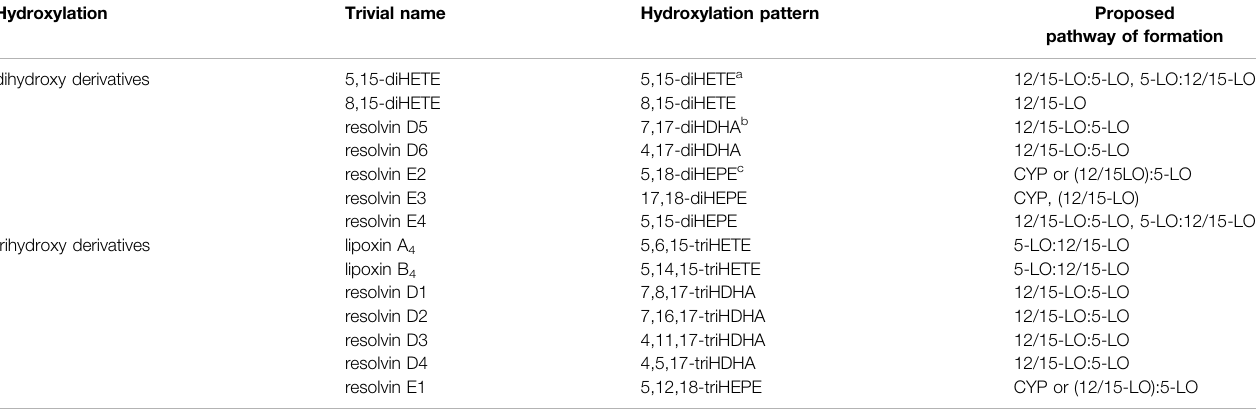
TABLE 1 | Di- and trihydroxylated oxylipins derived from AA, EPA and DHA. Hydroxylation Trivial